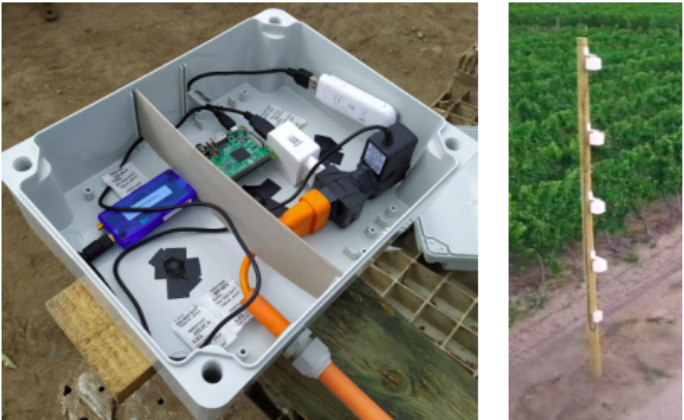
Figure 2. Internet of things (IoT) platform installed on experimental field composed by temperature and humidity